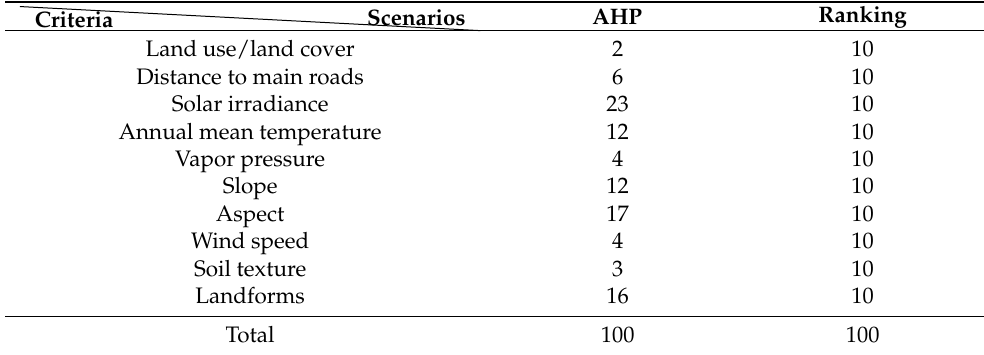
Table 9. Weighting (%) of the criteria influencing the site-suitability for the development of solar farms under the AHP and ranking scenarios.